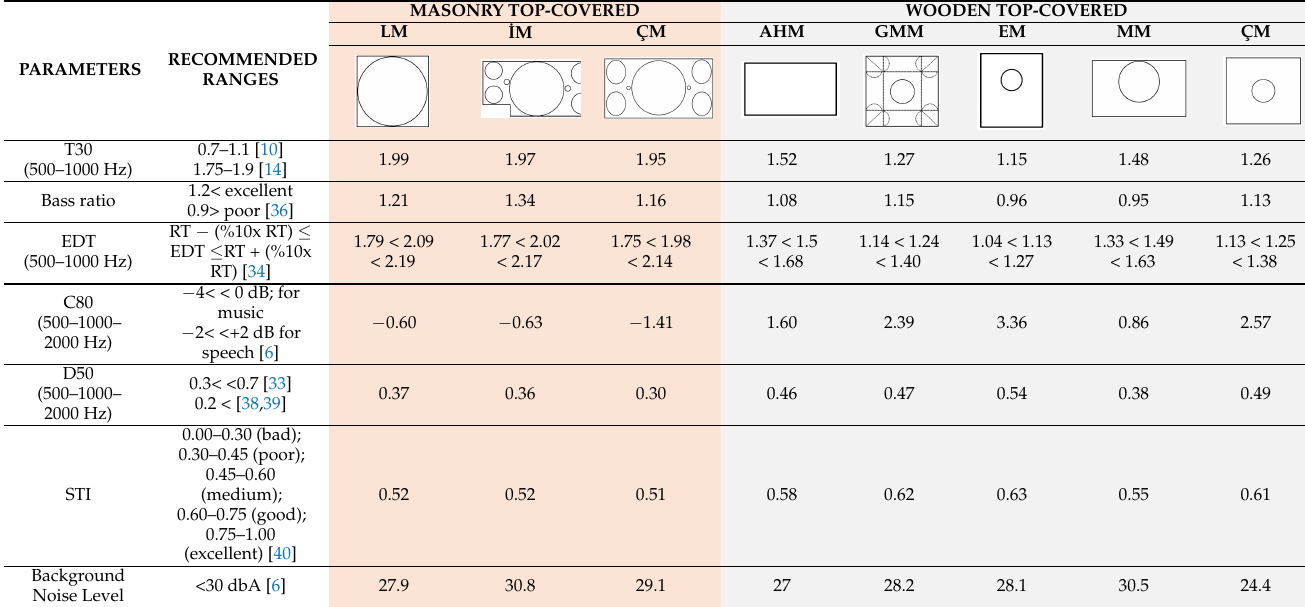
Table 12. The measured values of acoustical parameters in eight mosques and recommended values. ( masonry top- covered mosques wooden top-covered mosques) .